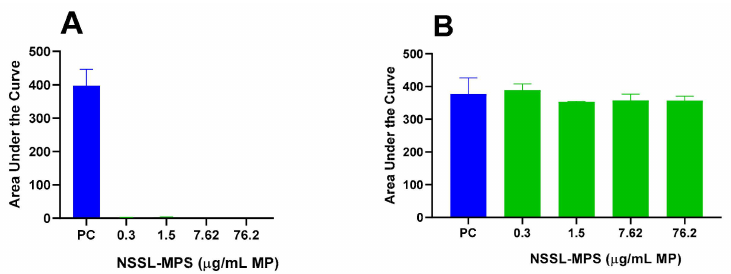
Figure 3. NSSL-MPS e ff ect on platelet aggregation and collagen-induced platelet aggregation. The capacity of NSSL-MPS to induce platelet aggregation ( A ) and modify collagen-induced platelet aggregation ( B ) were assessed. Briefly, NSSL-MPS at di ff erent concentrations (0.304, 1.52, 7.62 or 76.2 µ g / mL MPS) were incubated in platelet-rich plasma for 15 min at 37 ◦ C. Platelet aggregation was monitored in real time using light transmission aggregometry. AUC, Area Under the Curve; PC, Positive Control (positive control is collagen).